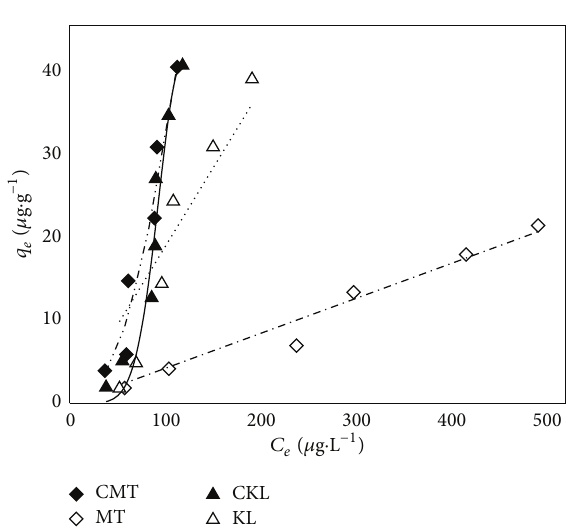
Figure 7: Isothermal sorption plot of pyrene by the bare clays and their complexes at 298 K.